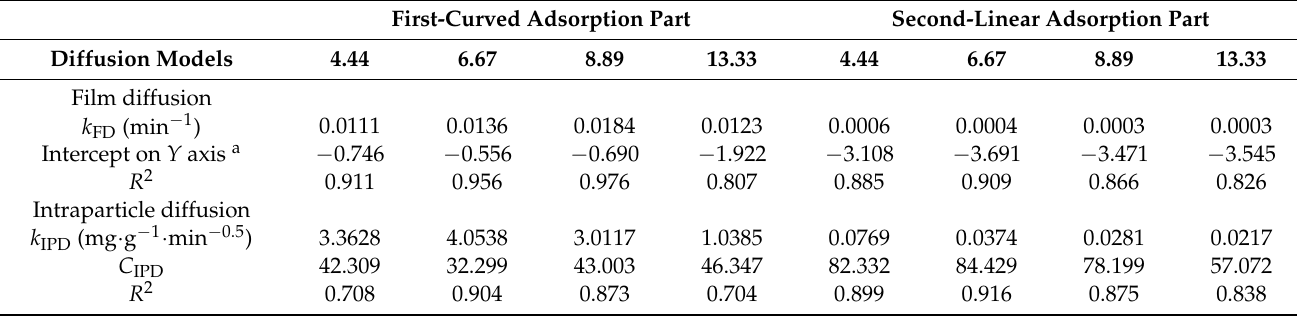
Table 2. Parameters of RBBR adsorption kinetics fitted by the film diffusion (Boyd plot) and intraparticle diffusion (Weber and Morris plot) models at T = 310